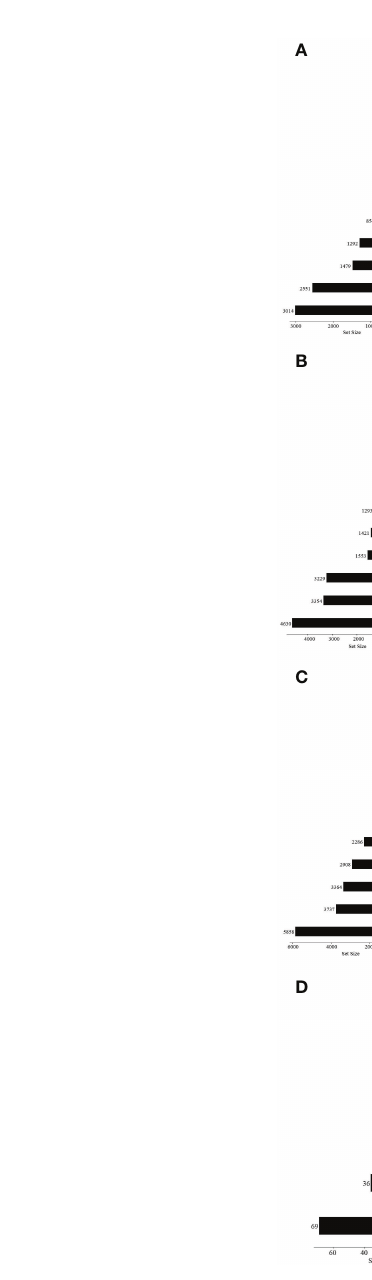
FIGURE 4 The distribution of DEGs across fl ower developmental stages in FD, MU, and LH. (A) The distribution of DEGs across fl ower developmental stages (BS, IF, FB, DE) in FD libraries. (B) The distribution of DEGs across fl ower developmental stages (BS, IF, FB, DE) in MU libraries. (C) The distribution of DEGs across fl ower developmental stages (BS, IF, FB, DE) in LH libraries. (D) The distribution of intersection DEGs across four fl ower developmental stages (BS, IF, FB, DE) and across the three tree peony varieties (LH, MU and